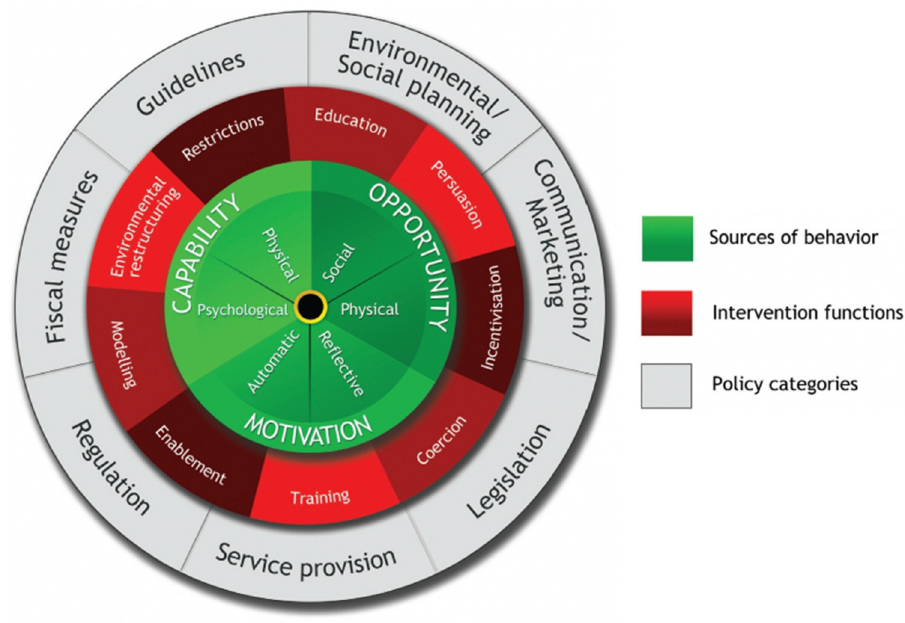
Figure 1. The Behavior Change Wheel